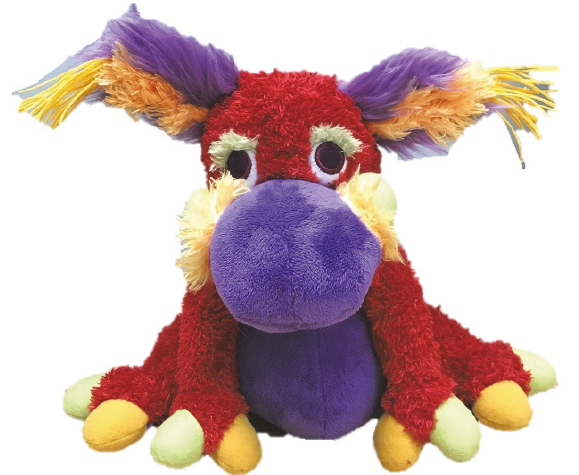
Figure 3: Completely dressed SAR used during SAR-child interac- tions in this